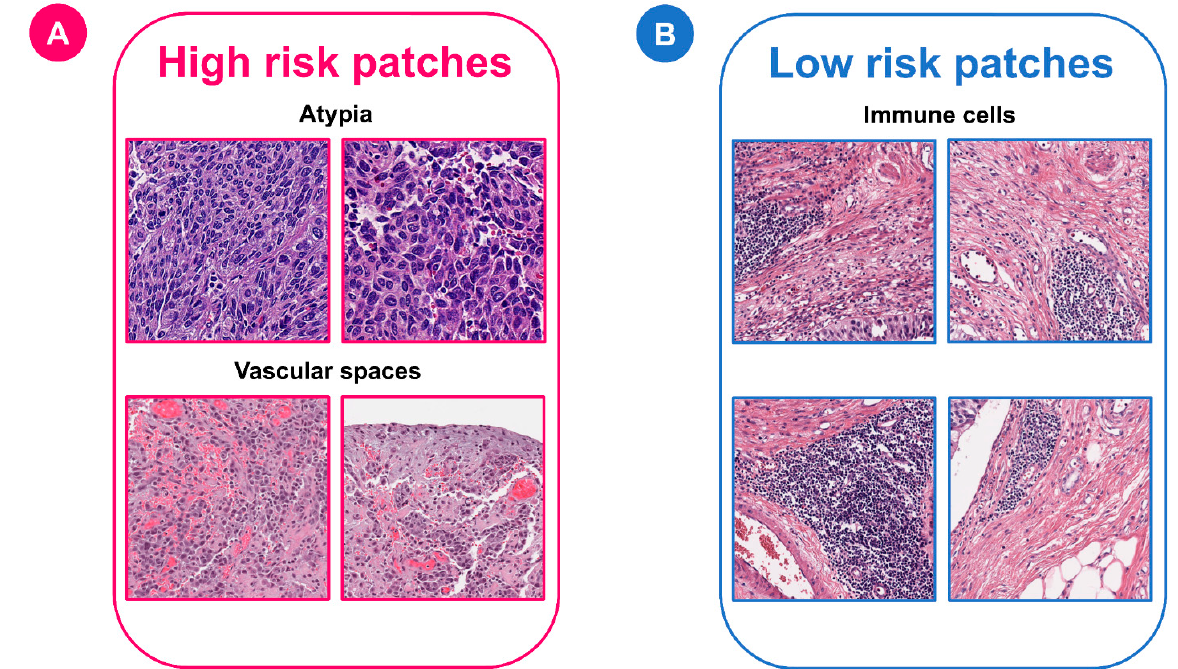
Figure 5. Representative examples of patches classified as high or low risk by the MibcMLP model. The top 200 most predictive patches were analyzed by expert uropathologists who was unaware of the risk scores. ( A ) Features predicting a high mortality risk included cellular atypia and vascular space. ( B ) Features predicting a low risk of death was the presence of immune cells.